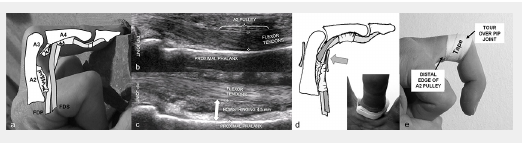
increases flexion force of a single finger to up to 50%. The half/ open crimp position (C) with PIP joints flexed to about 80° thereby generating most flexion torque. Squeezing and distorting the fingertips into a crack (D) is sometimes the only way to hold on.